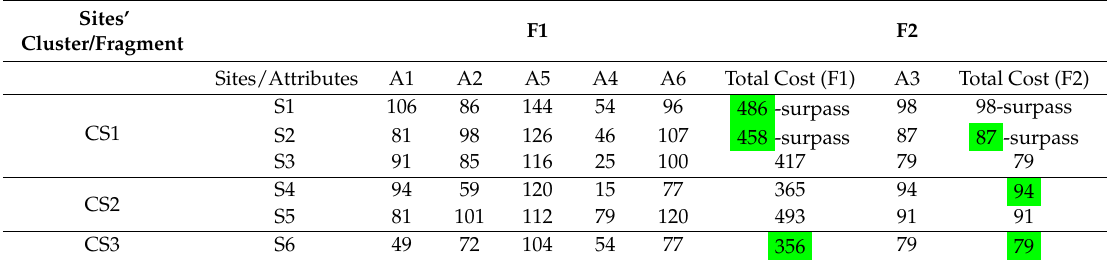
Table 21. Fragment allocation over sites (Scenario 3), [7].